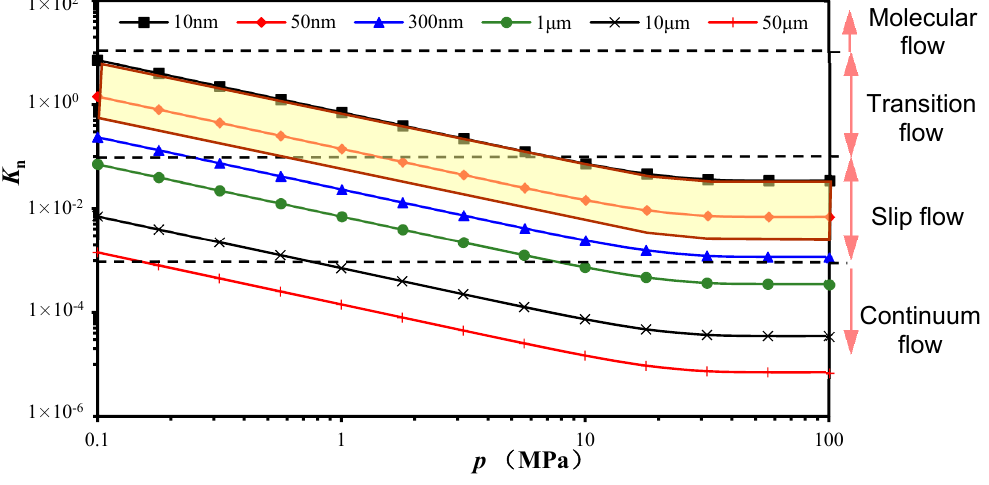
Figure 5. The Knudsen number of different pore diameters.